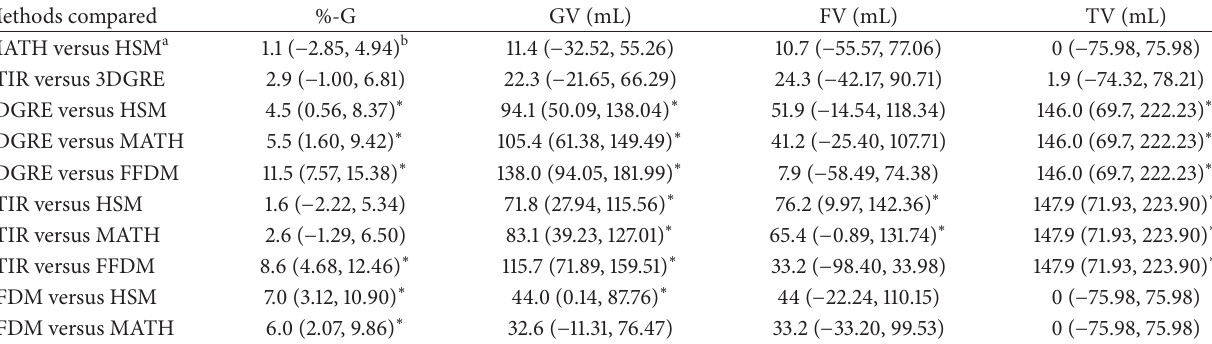
Table 2: Mean differences and 95% confidence interval in percent glandular tissue (%-G), gland volume (GV), fat volume (FV), and total breast volume (TV) by Tukey’s